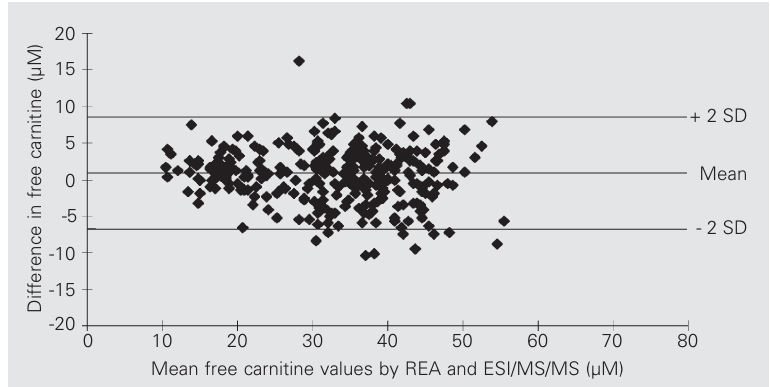
1. Bland-Altman plot of the difference, Vs, of the mean of paired values for free carnitine measurement comparing the radioenzymatic (REA) and ESI/MS/MS methods (N = 312, mean ± SD = 0.6 ± 3.7).